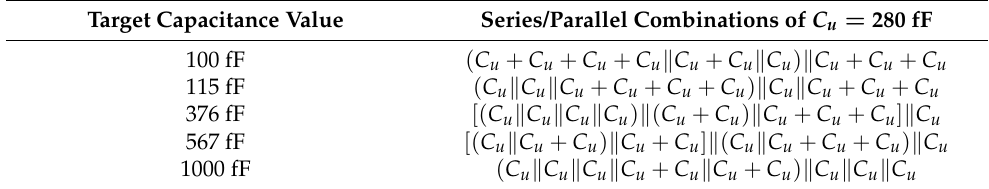
Table 1. Series/parallel combinations of